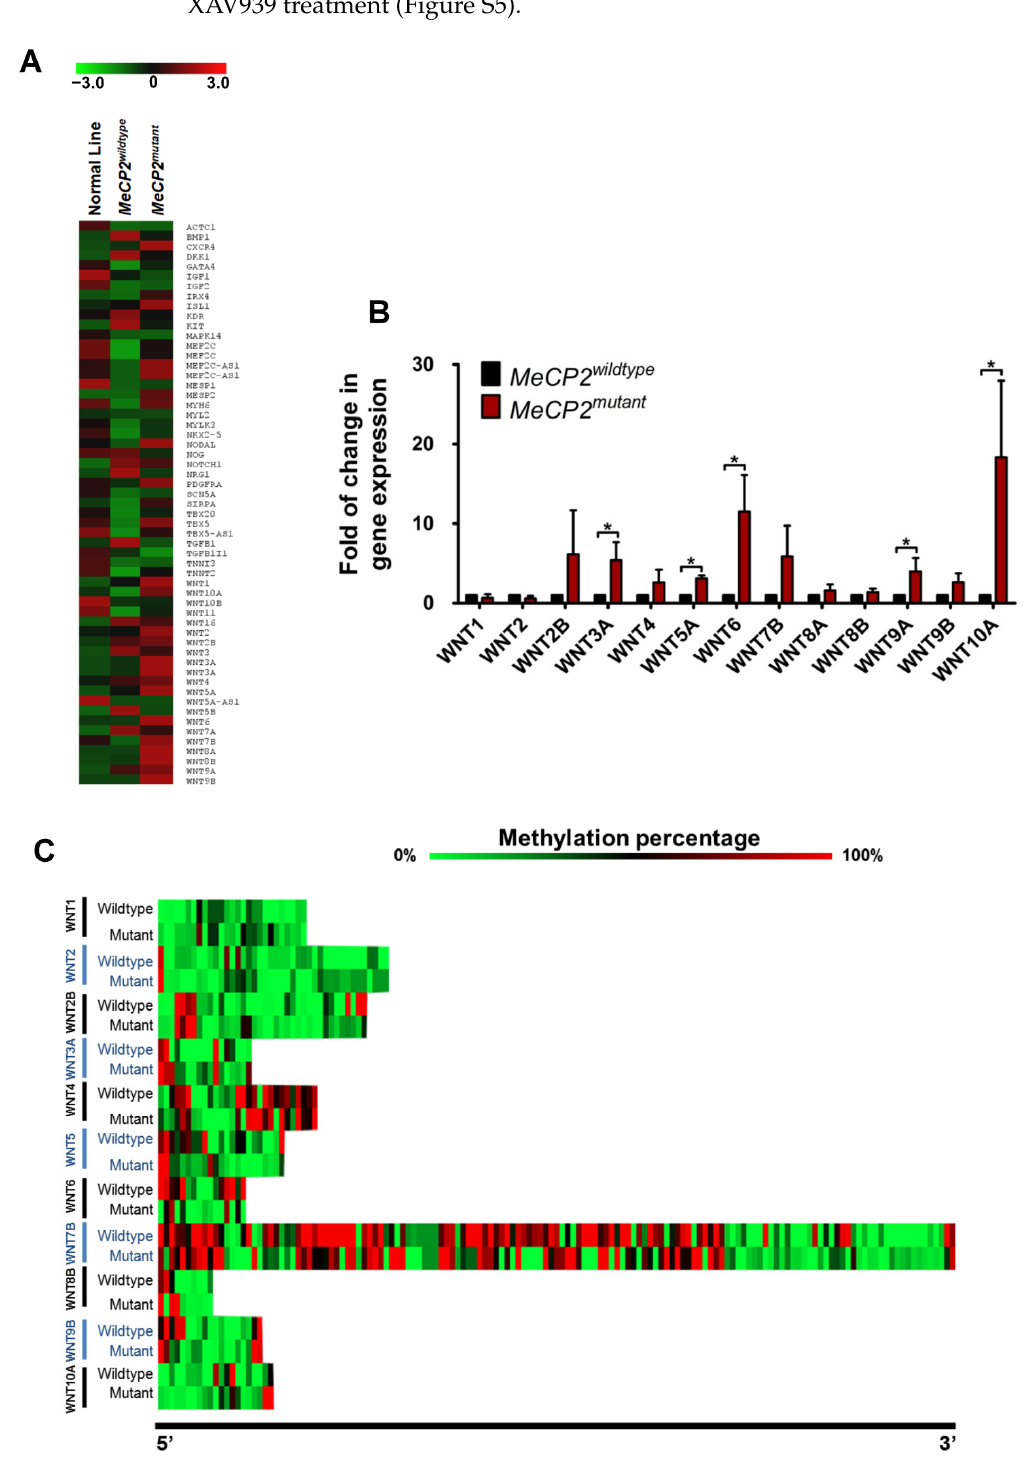
Figure 6. Up-regulated expression of WNT genes is associated with MeCP2 mutation. ( A ) Heat map analysis of the expression of WNT genes as identified by RNA-sequencing analysis in the iPSC- derived cardiomyocytes. ( B ) Quantitative PCR analysis of WNT family members in cardiomyocytes derived from isogenic iPSC lines from a Rett syndrome patient. N = 4 individual experiments from 4 independent samples collected from each group. ( C ) Heatmap analysis of the methylation status of selected WNT family members. Data are represented as mean ± SEM. * p < 0.05. (See also Figure